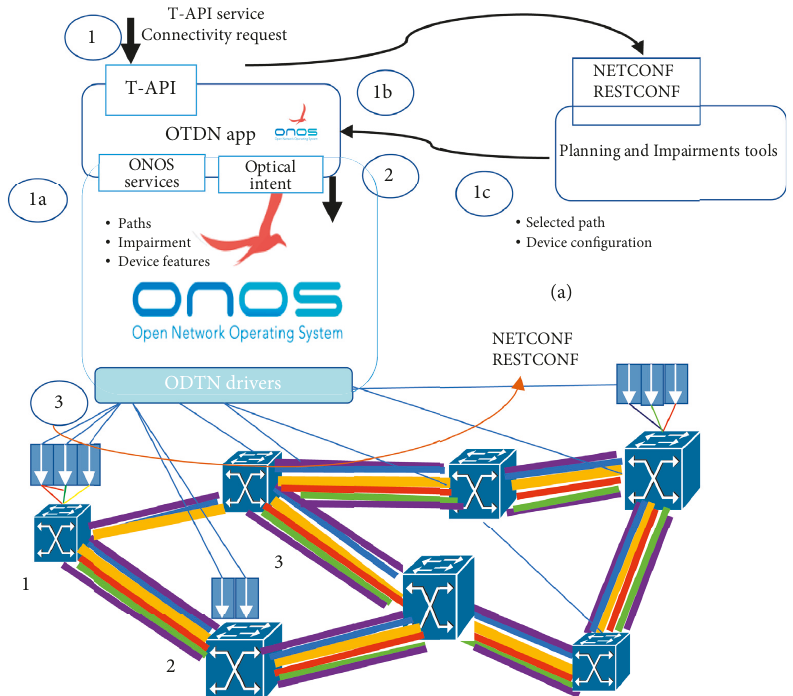
Figure 17: SDN reference architecture and procedures to configure a light path